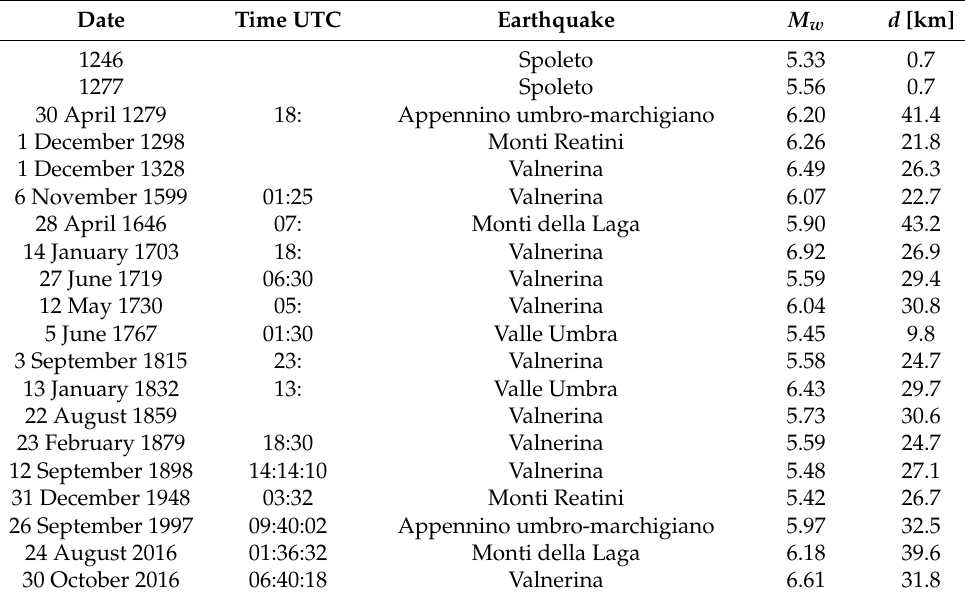
Figure 3. Expected maximum horizontal ground acceleration specified by the Italian Building Code [34] for type A soil and different return periods. Table 1. List of earthquakes representative of the seismic history of the